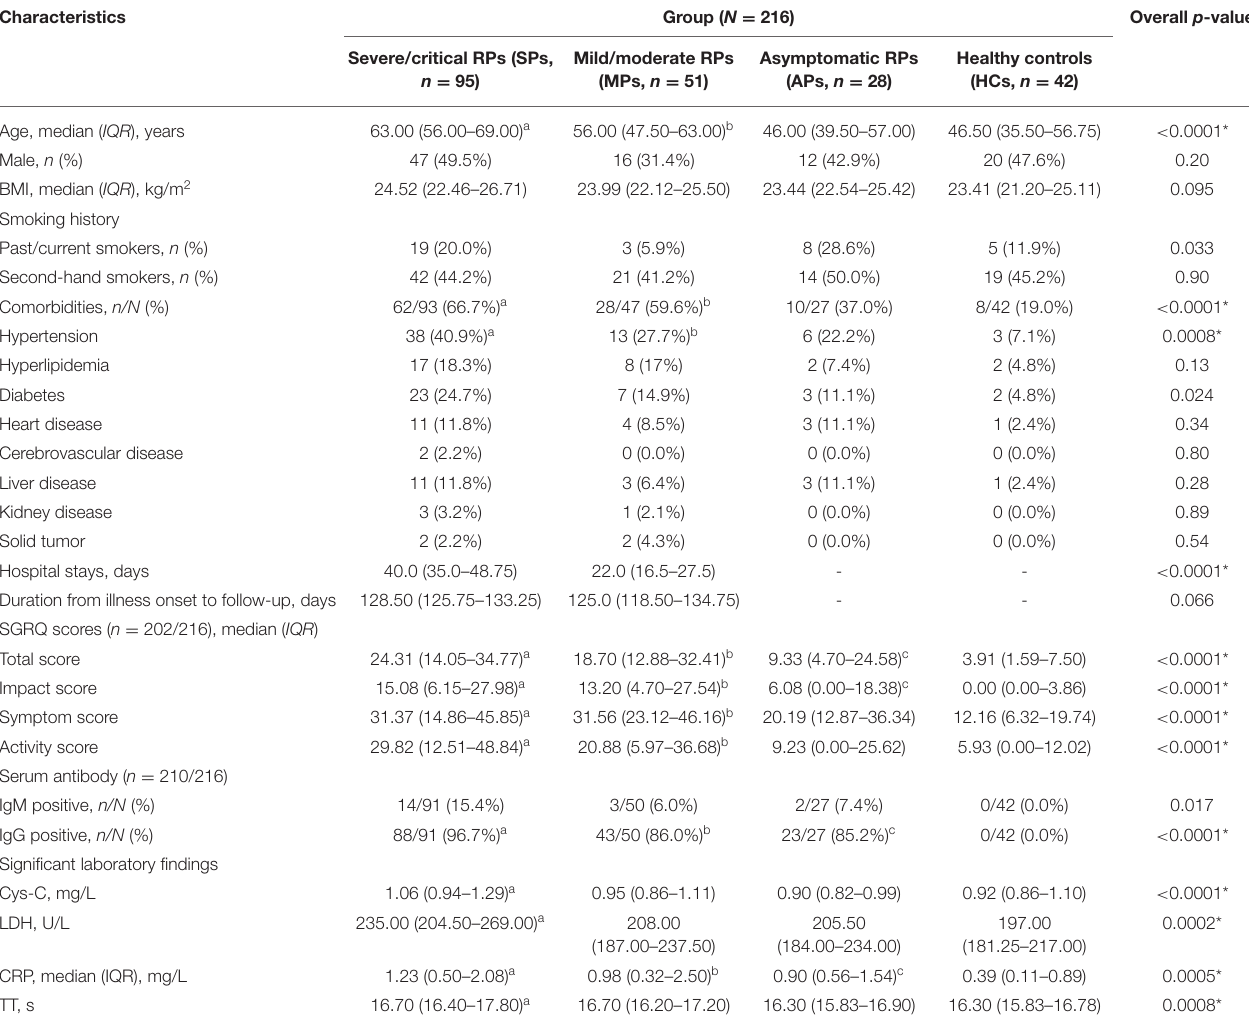
TABLE 1 | Clinical characteristics and St. George respiratory questionnaire in COVID-19 recovered patients at 3-month post-discharge. Characteristics Group ( N =